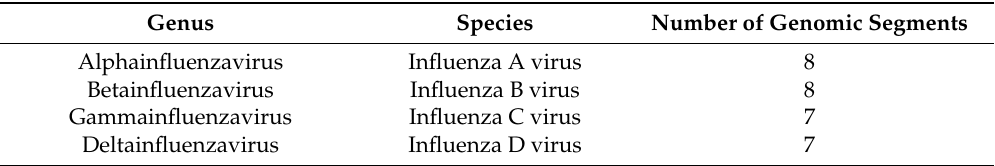
Table 1. Revised classification of influenza viruses in the family Orthomyxovirideae by International Committee on Taxonomy of Viruses